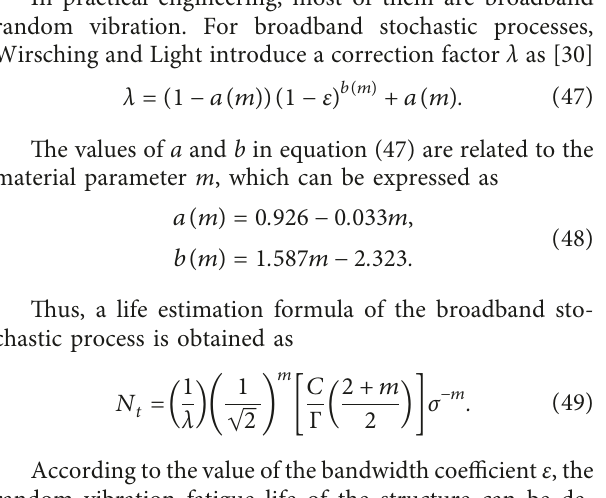
Figure 9: Comparison between the fatigue life model and the experimental data [31].